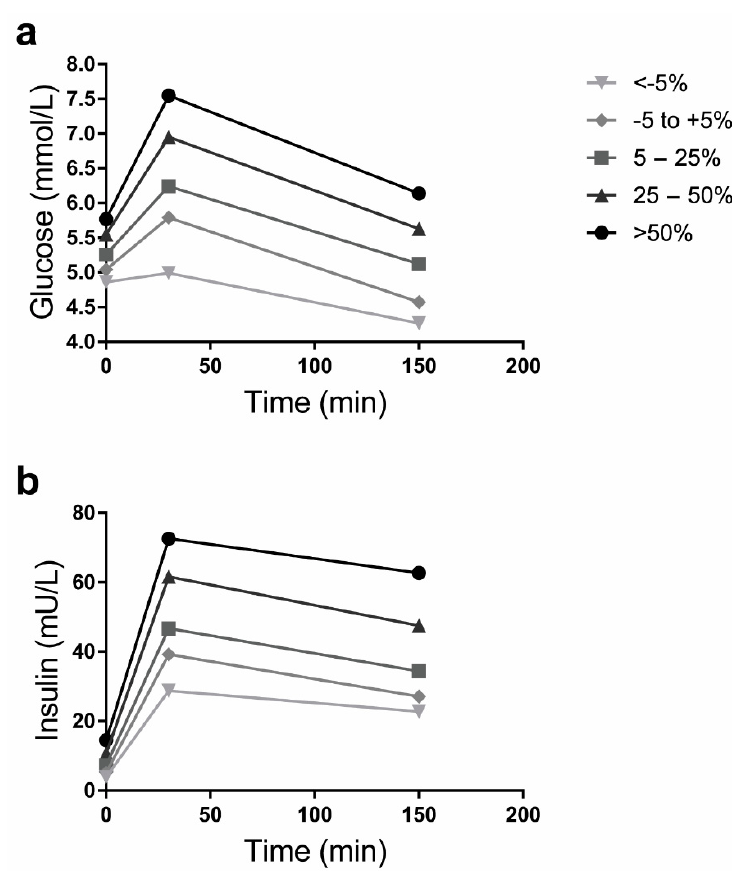
Figure 1. Estimated means of ( a ) glucose (mmol / L) and ( b ) insulin (mU / L) blood concentrations fasting, and at t = 30 and t = 150 min after a mixed meal challenge, stratified by adult weight change ( N = 1758) and adjusted for sex, age, BMI at age 20, ethnicity, education, smoking, alcohol consumption, physical activity, and family history of diabetes.